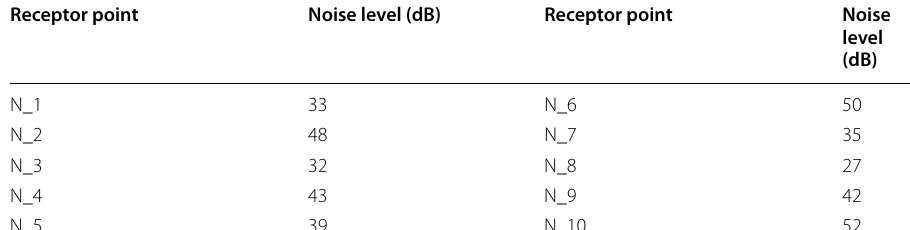
Table 6 Noise level of each receptor point Receptor point